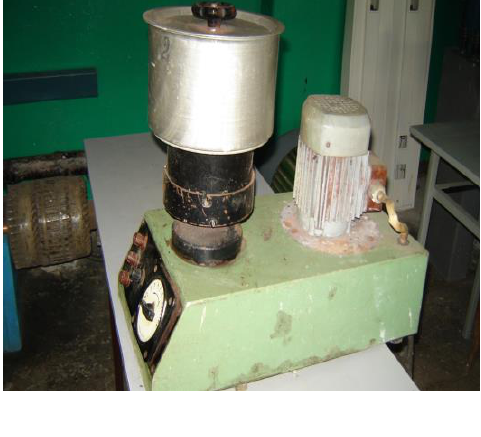
Fig.2. Mill MPR-2 :Technical characteristics: Productivity, samples / hour - 10; Grinding time of one sample, min-3; Mass of samples, Mr -100; Voltage, at 380; Power, kW - 0.6; Speed, rpm -7000